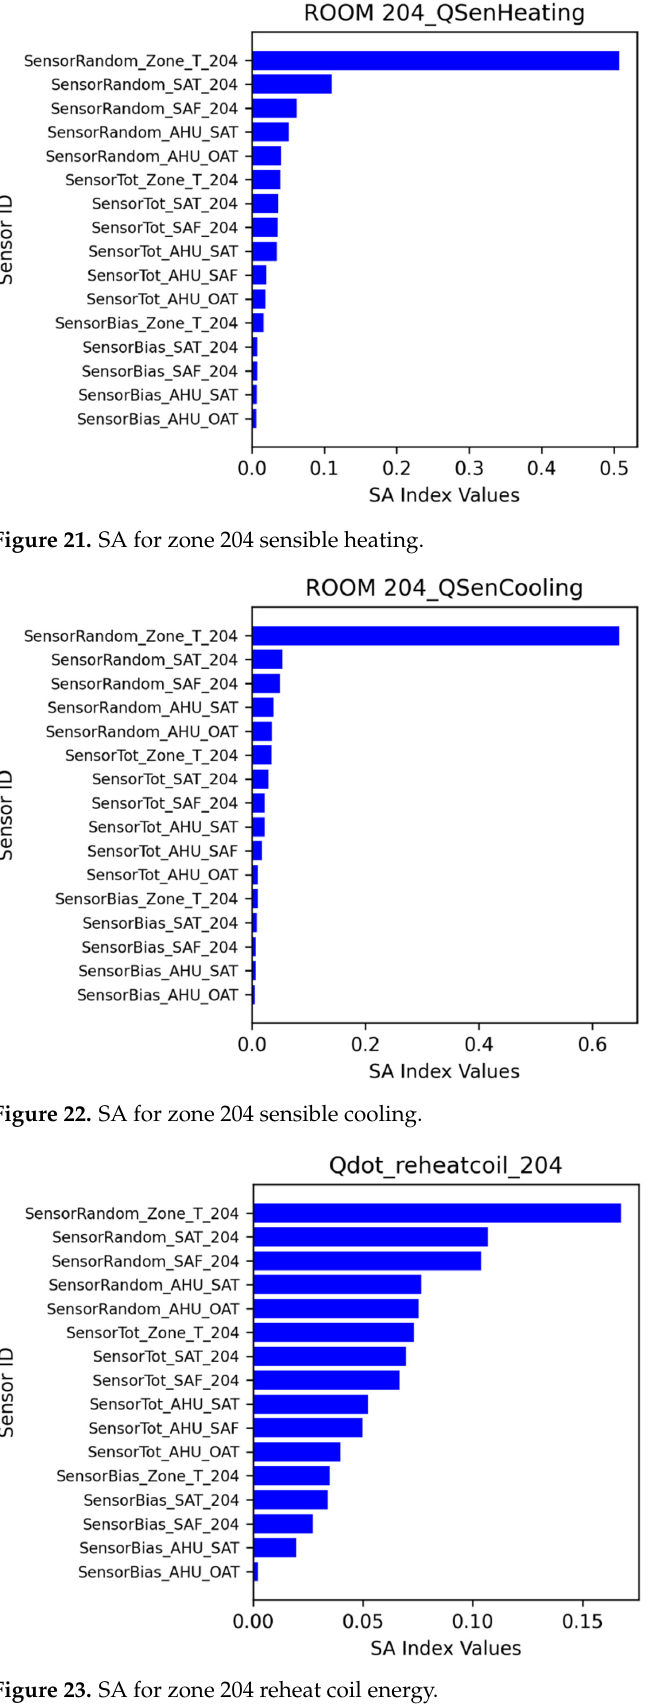
Figure 24. SA for zone 204 PPD. 5.2.3. Zone 102 SA Analysis Sensitivity analysis for zone 102 was performed similarly to that of zone 204. The impacts of sensor errors on four energy consumption variables (zone temperature, zone sensible heating, zone sensible cooling, and reheat coil energy consumption) and one ther- mal comfort variable (zone PPD) were demonstrated. Figure 25 shows the ranking of the sensitivity index for zone 102 air temperature. The system-level sensors and zone-level sensors affected the zone temperature. The zone air temperature sensor with random er- ror had the highest sensitivity index. Figure 26 shows the ranking of the sensitivity index for zone sensible heating. The zone air temperature sensor with random error had the highest sensitivity index. Figure 27 shows the zone sensible cooling impacts from the sen- sors. Figure 28 shows the impacts on reheat coil energy. Figure 29 shows the sensitivity index ranking for zone thermal comfort (PPD). Across zone 102 output variables, random errors consistently had stronger impacts.